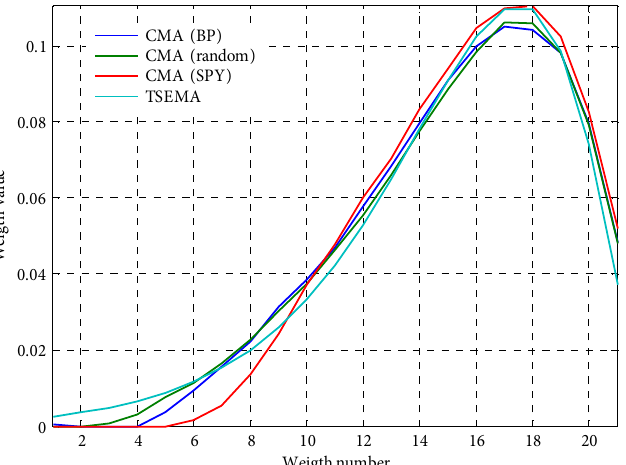
Fig. 5. Weights of various methods generated using various data (data name in brackets)